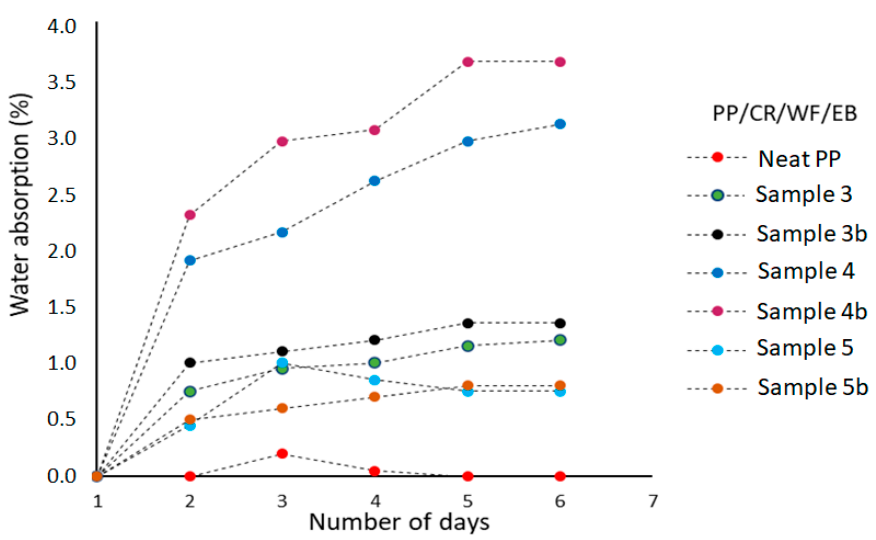
Figure 8. The percentages of water absorption for the PP/GTR/WF composites. Here, #b denotes samples prepared in the presence compatibilizer.